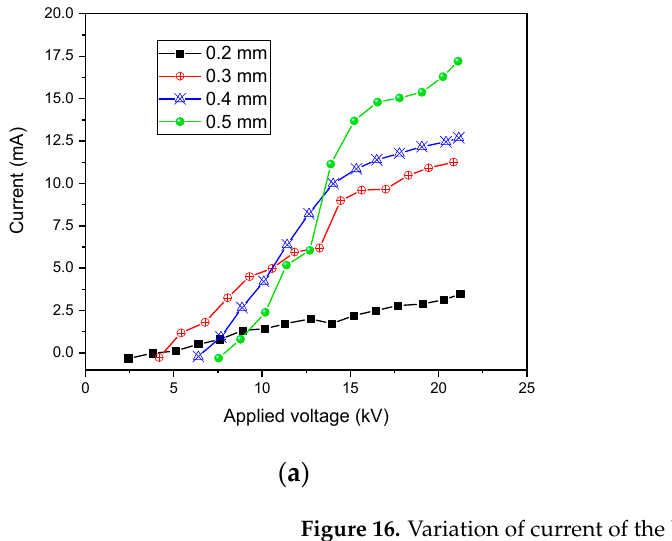
Figure 16. Variation of current of the DBD ( a ) and breakdown voltage as a function of the interelec- trode distance ( b ).